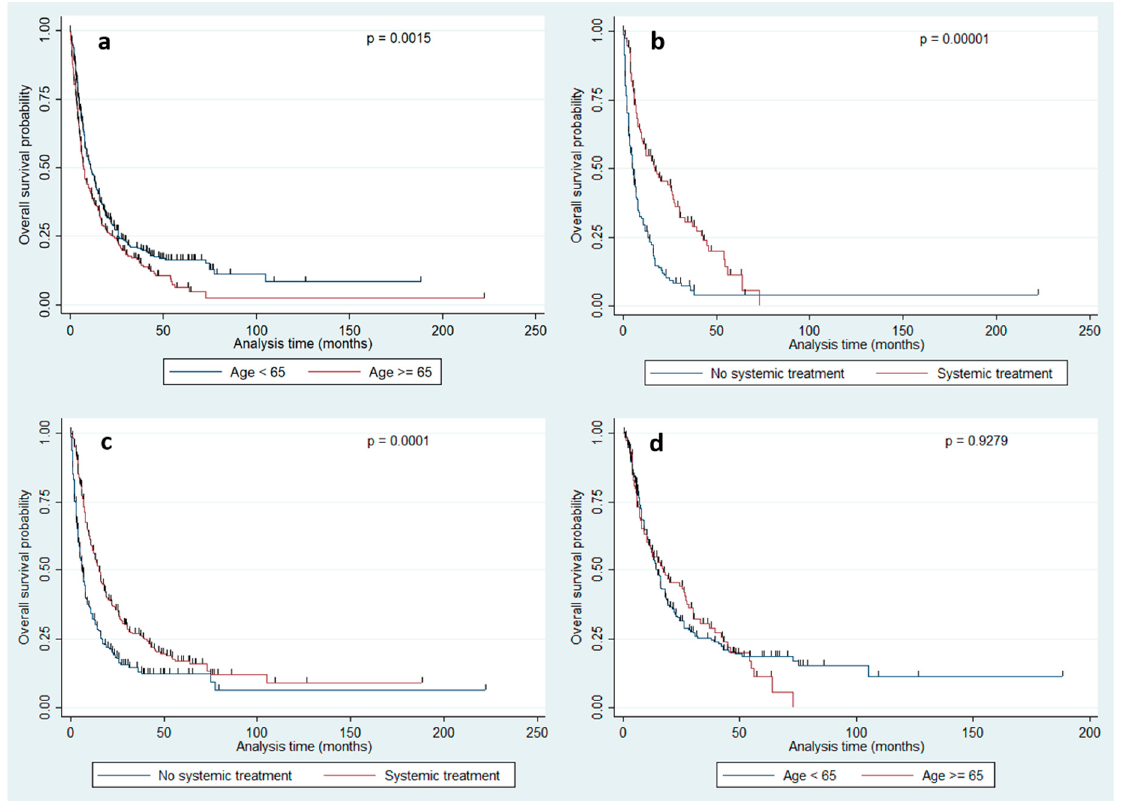
Figure 1. (a ) Overall survival of the entire population ( n = 807) stratified by age group (younger Table 65. years vs. 65 years and older). The elderly population shows a significantly poorer overall survival (median OS: 5.81 vs. 8.83; p = 0.0015). ( b ) The comparison of overall survival between patients who received systemic treatment or not applied to the entire population showed a significantly better outcome in patients receiving such treatment (median OS: 15.38 vs. 6.99 months, p = 0.00001). ( c ) The identical comparison applied to the elderly population confirmed the effects of systemic effect on overall survival (median OS: 10.33 vs. 3.87 months, p = 0.0001). ( d ) When analyzing only patients who received systemic treatment, no significant impact of age group was detectable anymore ( p = 0.927).